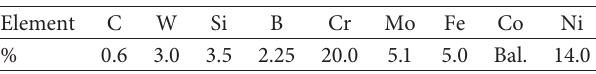
Table 2: Chemical composition of Co powder used in the ex- periment (weight).